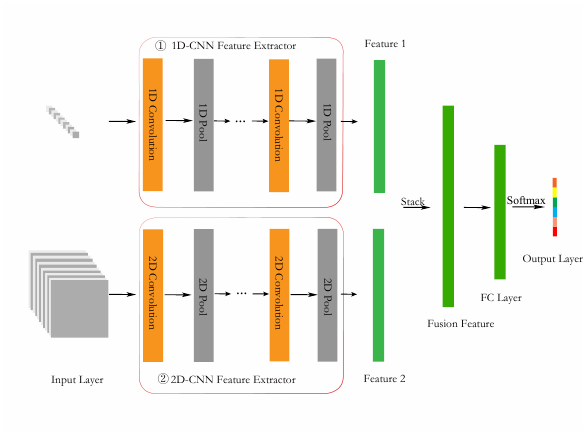
Figure 3. The architecture of Features Fusion